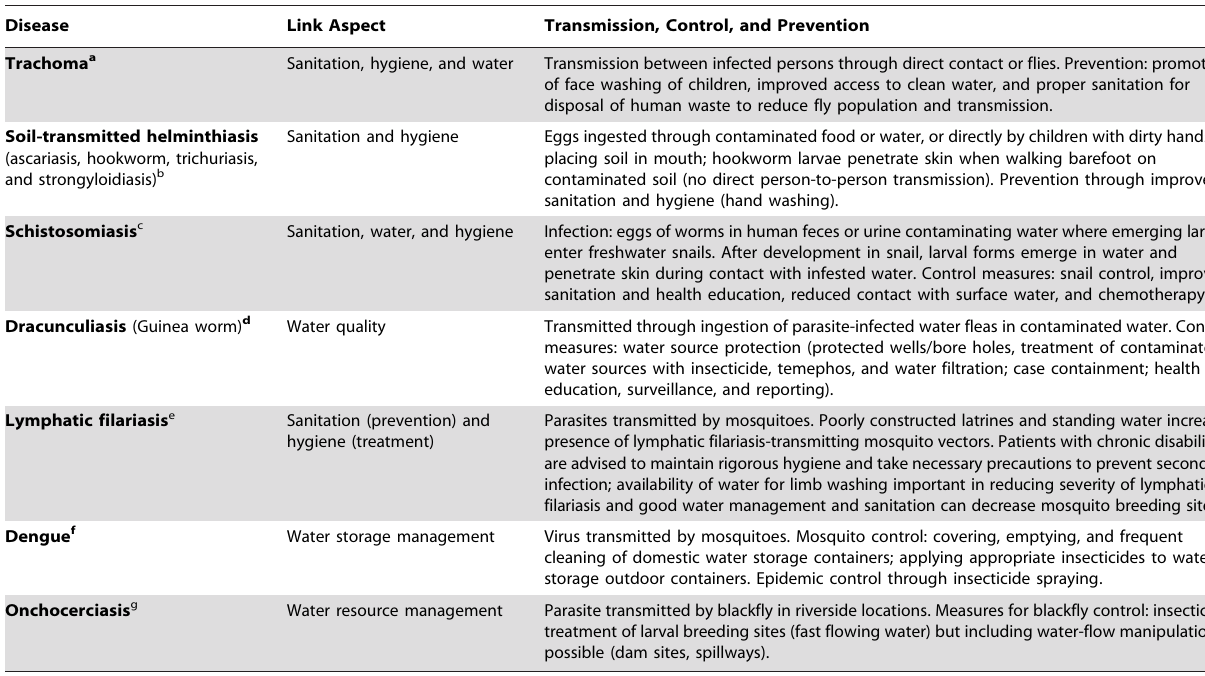
Table adapted from ’’WASH: the silent weapon against NTDs‘‘ [36]. Table represents the strength of connection between, and potential impact of, WASH and disease, starting at the top, where WASH impact on disease is likely to be strongest and moving to the bottom of the table, where impact may be weakest. a World Health Organization, ‘‘Prevention of blindness and visual impairment’’ 2012. http://www.who.int/blindness/causes/priority/en/index2.html (accessed: 5 August 2012). b World Health Organization, ‘‘Intestinal worms’’ 2012. http://www.who.int/intestinal_worms/en/ (accessed 5 August 2012); World Health Organization, ‘‘Neglected tropical diseases’’ 2012. http://www.who.int/neglected_diseases/diseases/strongyloidiasis/en/ (accessed: 5 August 2012). c World Health Organization, ‘‘Schistosomiasis: fact sheet no. 115’’ 2012. http://www.who.int/mediacentre/factsheets/fs115/en/index.html (accessed: 5 August 2012). d World Health Organization, ‘‘Drancunculiasis: fact sheet no. 359’’ 2012. http://www.who.int/mediacentre/factsheets/fs359/en/index.html (accessed: 5 August 2012). e World Health Organization, ‘‘Lymphatic filariasis: fact sheet no. 102’’ 2012. http://www.who.int/mediacentre/factsheets/fs102/en/index.html (accessed: 5 August 2012). f World Health Organization, ‘‘Dengue and severe fever: fact sheet no. 117’’ 2012. http://www.who.int/mediacentre/factsheets/fs117/en/index.html (accessed: 5